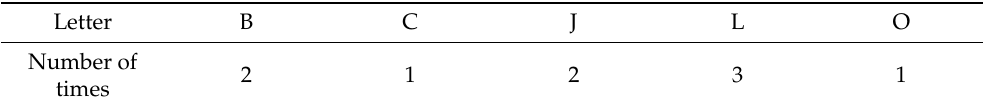
Table 2. Statistical results of letter